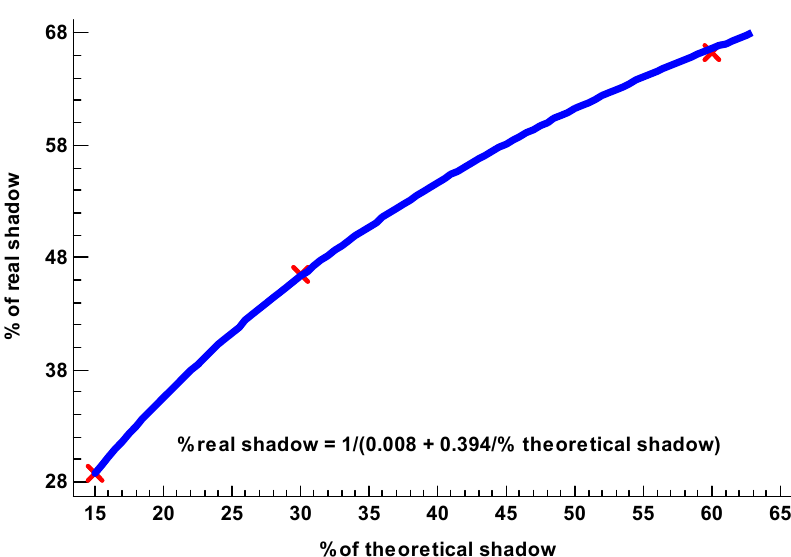
Figure 9. Reduction in PAR radiation produced by shading treatments of 15%, 30% and 50% in regards to the control treatment (0%). Figure shows the average values from October to